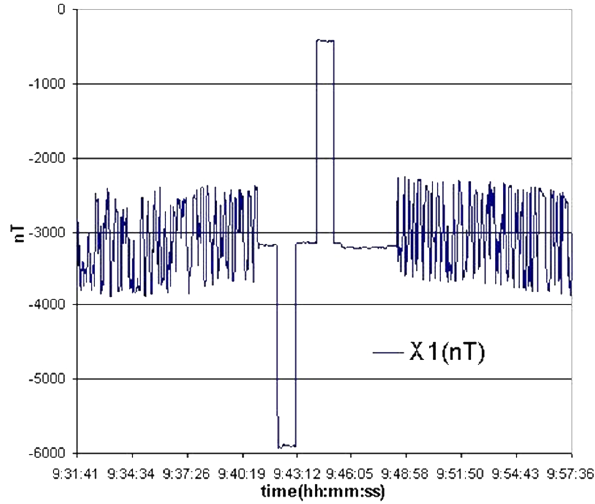
Figure 8. Detailed view of the register data by Sensor 1 x axis, minutes before and after the application of magnetic pulses (thermal chamber ON-OFF).